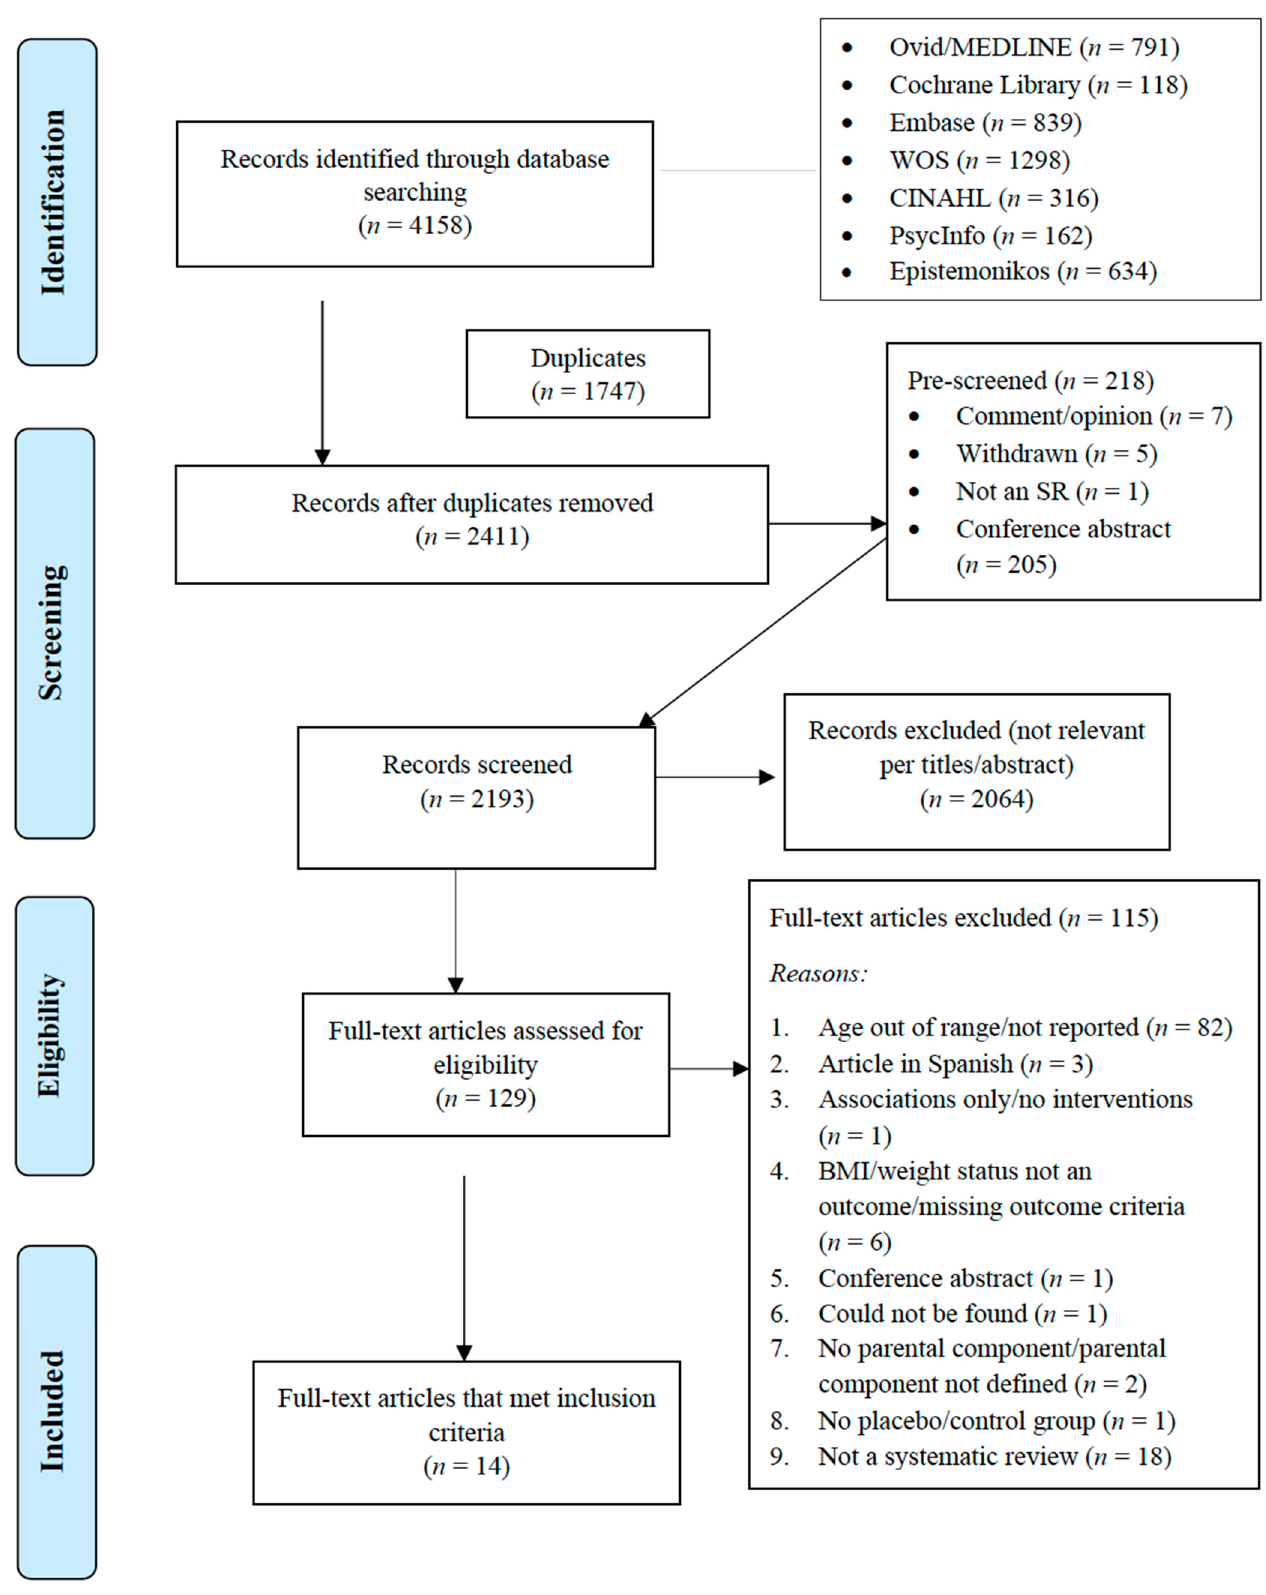
Figure 1. Flowchart of the process of literature search and extraction of studies meeting the inclusion criteria.